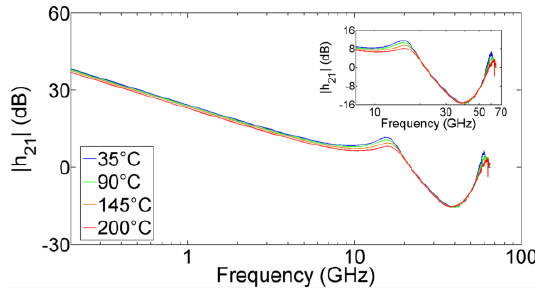
Figure 8. Measured h 21 from 0.2 to 65 GHz for a GaN HEMT at V DS = 30 V and V GS = −3 .5 V under four ambient temperatures: 35 °C, 90 °C, 145 °C, and 200 °C.